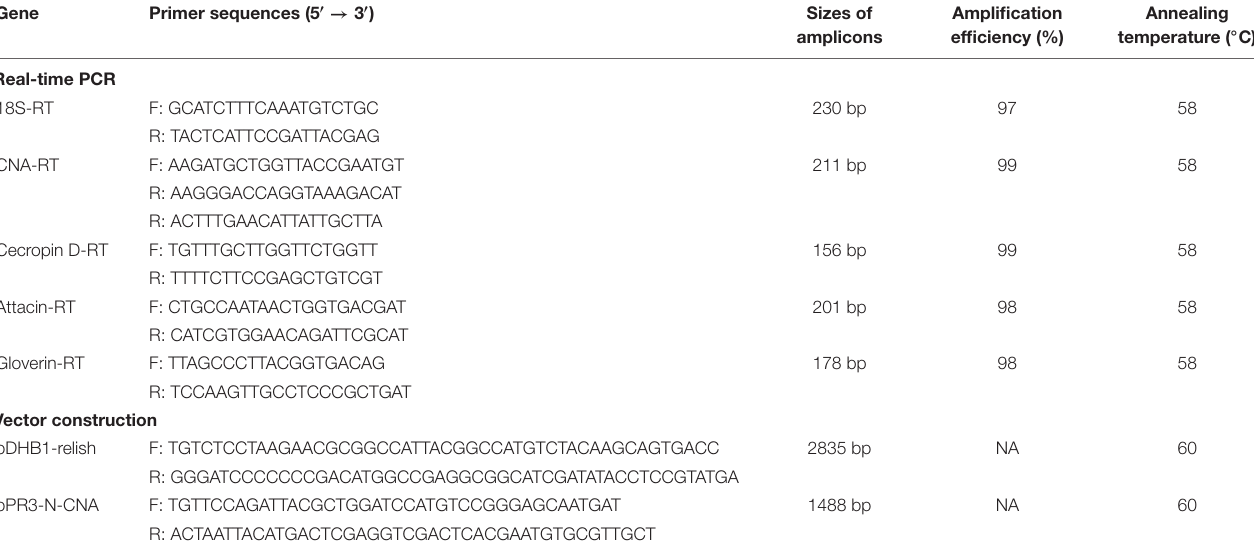
TABLE 1 | Primers used in this study. Gene Primer sequences (5 (cid:48) → 3 (cid:48)